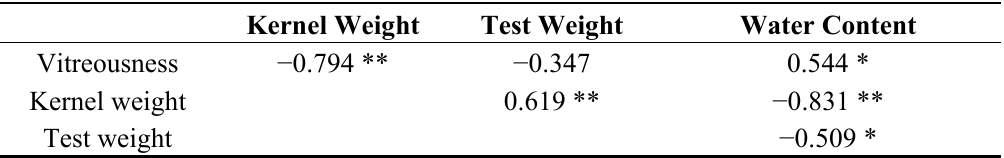
Table 4. Correlation coefficients between physical characteristics of